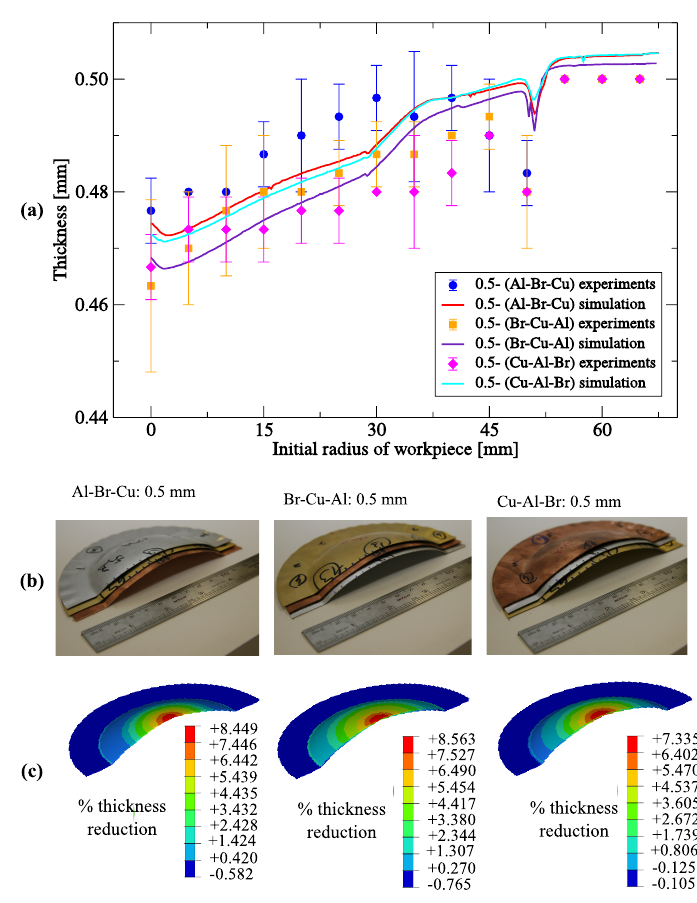
Figure 13. ( a ) Thickness variation of the deformed 0.5 mm stacked metal sheets with respect to the initial radius of workpiece. Snapshots of half sectional views of deformed stacked metal sheets in ( b ) experiments and ( c ) numerical